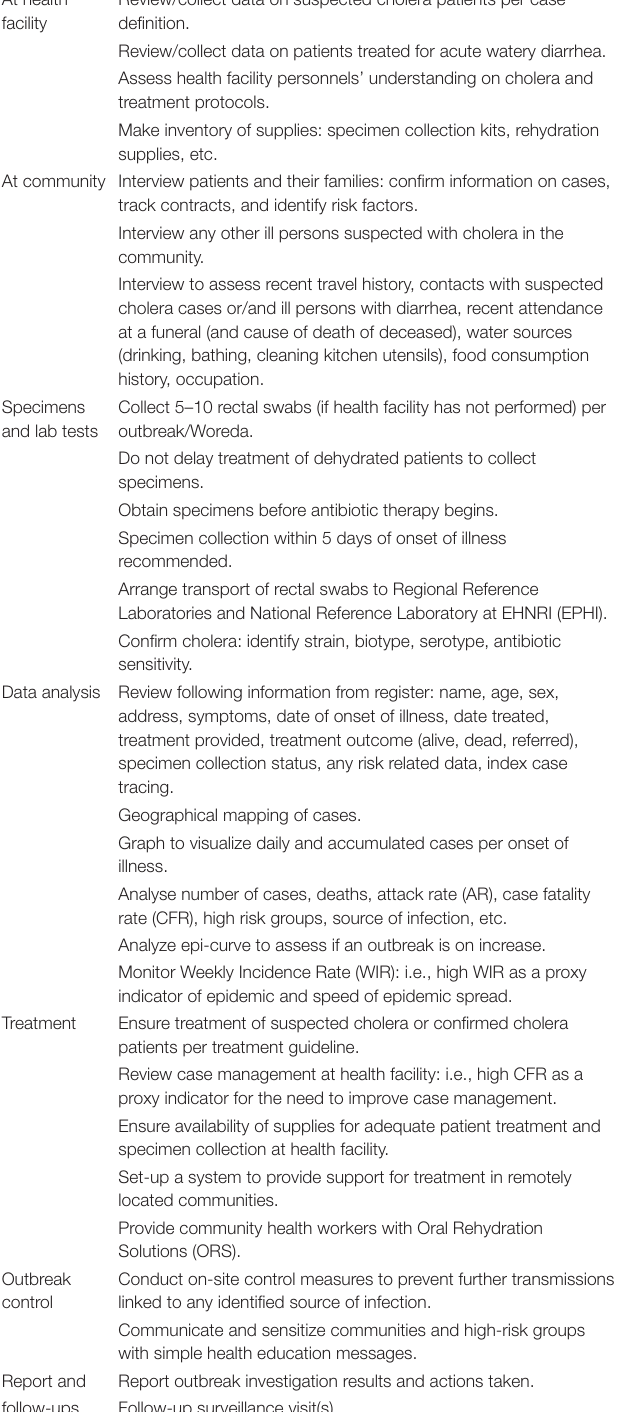
TABLE 2 | Activities of a Rapid Response Team (RRT) for cholera outbreak